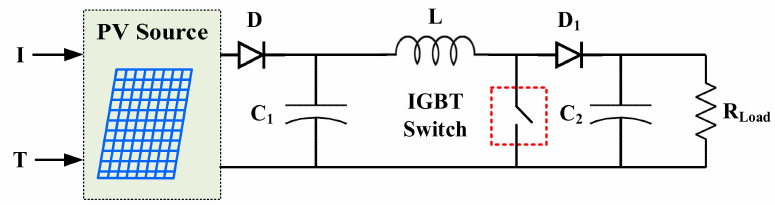
Figure 9. PV connected dc-dc boost